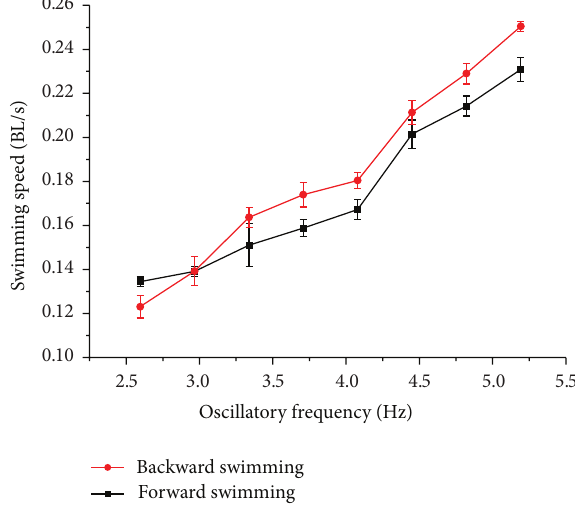
Figure 12: Speed test of the BCF swimming by changing the oscil- latory frequency and amplitude.